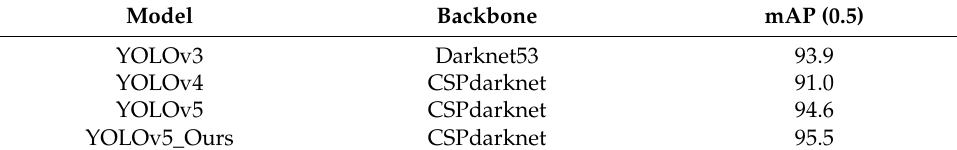
Table 4. Comparison of performance by previous YOLO models and YOLOv5_Ours.